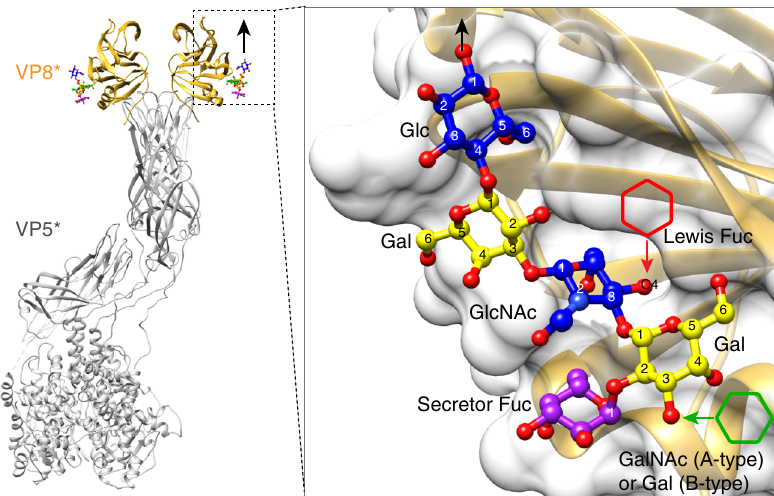
Fig. 8 Structural basis for resistance to rotavirus infection in non-secretors. P[6] VP8* in complex with H type I pentasaccharide is superimposed onto the structure of VP4 spike (PDB ID: 4V7Q) of P[3] animal strain RRV. The black arrow indicated how the glycan is extended from the C1 atom of Glc residue, and how the virus spike access host cell membrane. A close-up view of the P[6] VP8* with H-type I is shown in the inlet. The addition of a Lewis fucose via an α 1,4 linkage to the GlcNAc moiety is indicated by a red hexagon, suggesting that Lewis fucose would clash with VP8*. The addition of GalNAc or Gal at the non-reducing end of HBGA is noted by a green hexagon, which is projecting away from VP8* without making steric